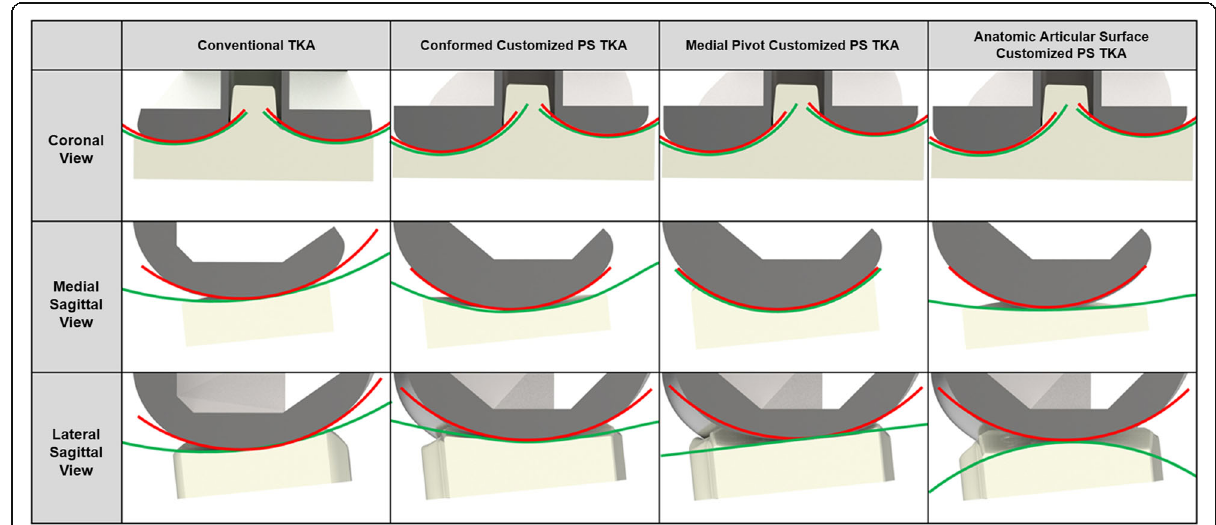
Fig. 4 Conventional and customized PS-TKAs with different TF joint conformity designs by applying the curvature radius ratio in the coronal, medial, and lateral